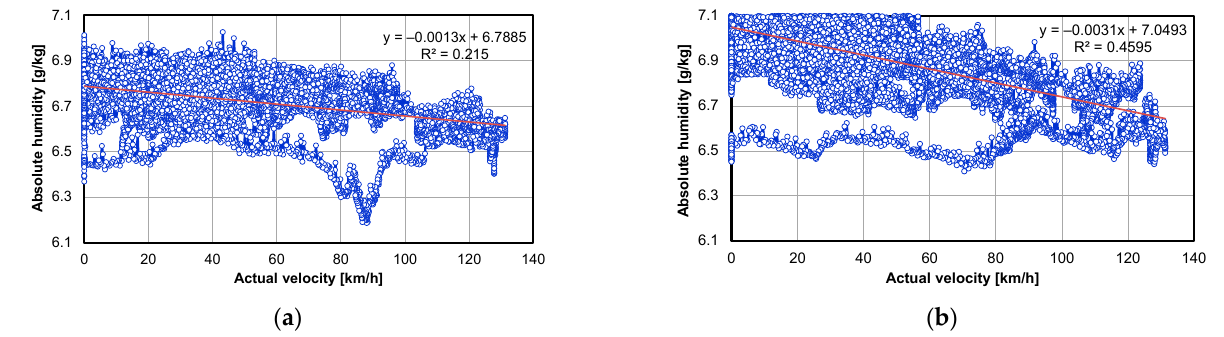
Figure 7. The absolute humidity versus actual velocity for: ( a ) plug-in; ( b ) HEV. The relative humidity during the tests is shown in Figure 8a for the plug-in and in Figure 8b for HEV. The relative humidity in the case of the plug-in was lower by 1–3% compared to that in the case of HEV. Such differences were higher for the lower velocities during the WLTC tests. It also resulted from conditions in the place where the dyno was located.